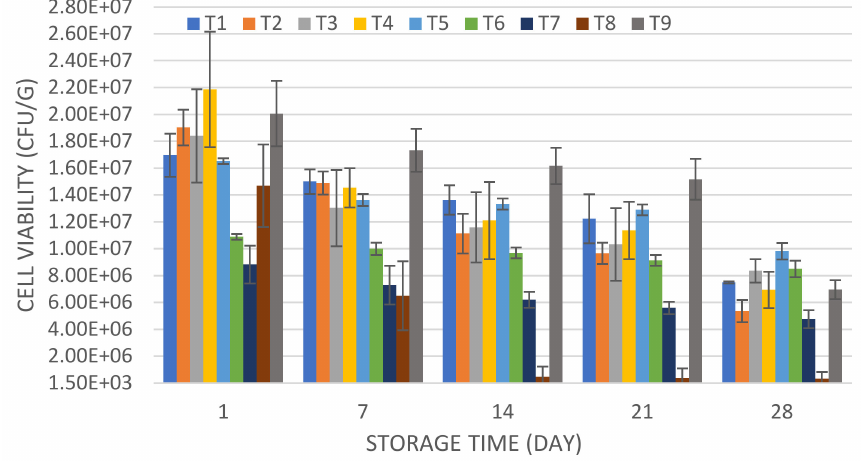
Figure 3. Cell viability (CFU / g) during storage: A) UTNGt28-based formulations; B) LacAT-based formulations. Legend: T1: UTNGt28 + S. thermophilus ATCC19258:1:1 ( g / g ); T2: UTNGt28 + S. thermophilus ATCC19258:1:3 ( g / g ); T3: UTNGt28 + S. thermophilus ATCC19258:3:1 ( g / g ); T4: UTNGt28; T5: LacAT + S. thermophilus ATCC19258:1:1 ( g / g ); T6: LacAT + S. thermophilus ATCC19258:1:3 ( g / g ); T7: LacAT + S. thermophilus ATCC19258:3:1 ( g / g ); T8: LacAT; T9: S. thermophilus ATCC19258. The values represent the means and standard deviations for n =